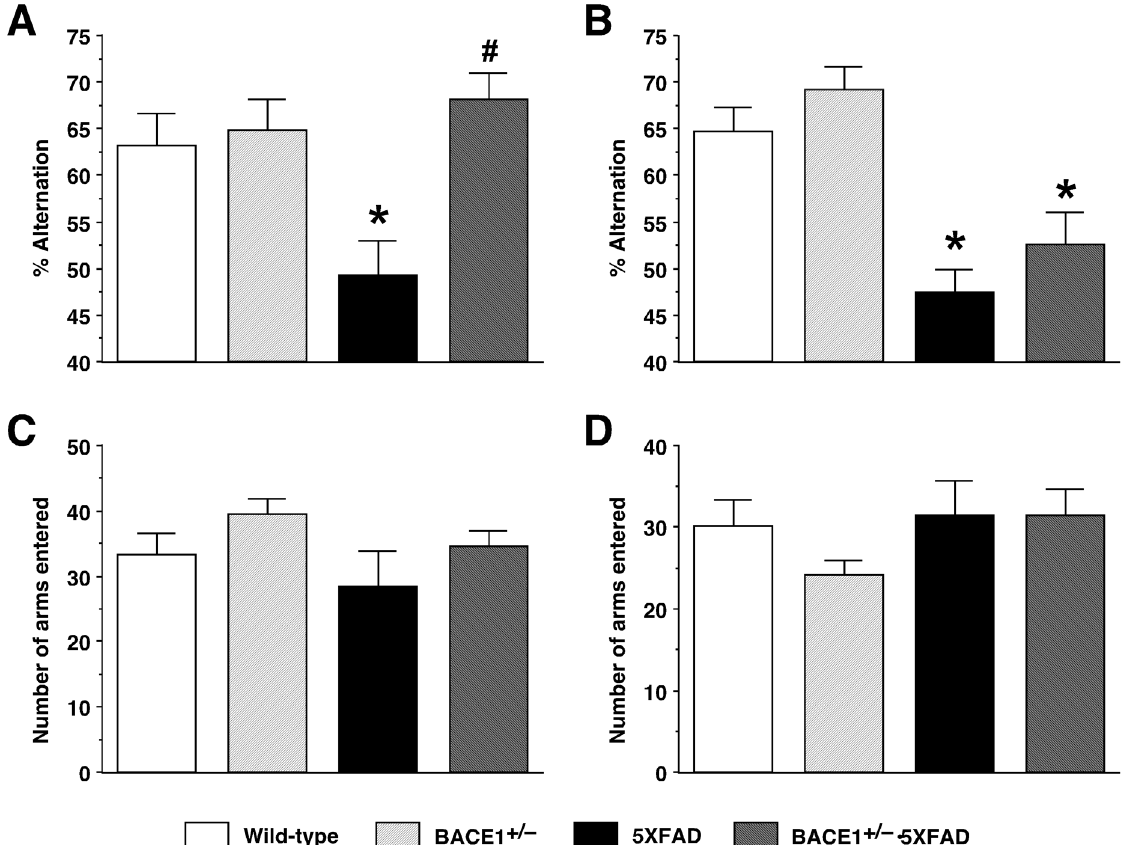
Figure1. Age-related effects of BACE1 + / 2 deletion on memory deficits in 5XFAD mice. Memory function of mice at 6 months ( A , C ) and15–18 months ( B , D ) of age was tested using the spontaneous alternation Y-maze task. ( A , B ) Spatial working memory, as assessed by the spontaneous alternation performance, is significantly impaired (around 50% chance levels) in 5XFAD mice irrespective of age compared to wild-type controls (* p , 0.05). Note that BACE1 + / 2 ? 5XFAD are rescued completely back to wild-type levels of alternation performance at 6 months but not at 15–18 months of age ( # p , 0.05 versus age-matched 5XFAD). n =5–12 mice per group. ( C , D ) Total number of arm entries reflecting exploratory activities of mice in the Y-maze does not differ between the four groups irrespective of age. n =5–12 mice per group. All data are presented as mean 6